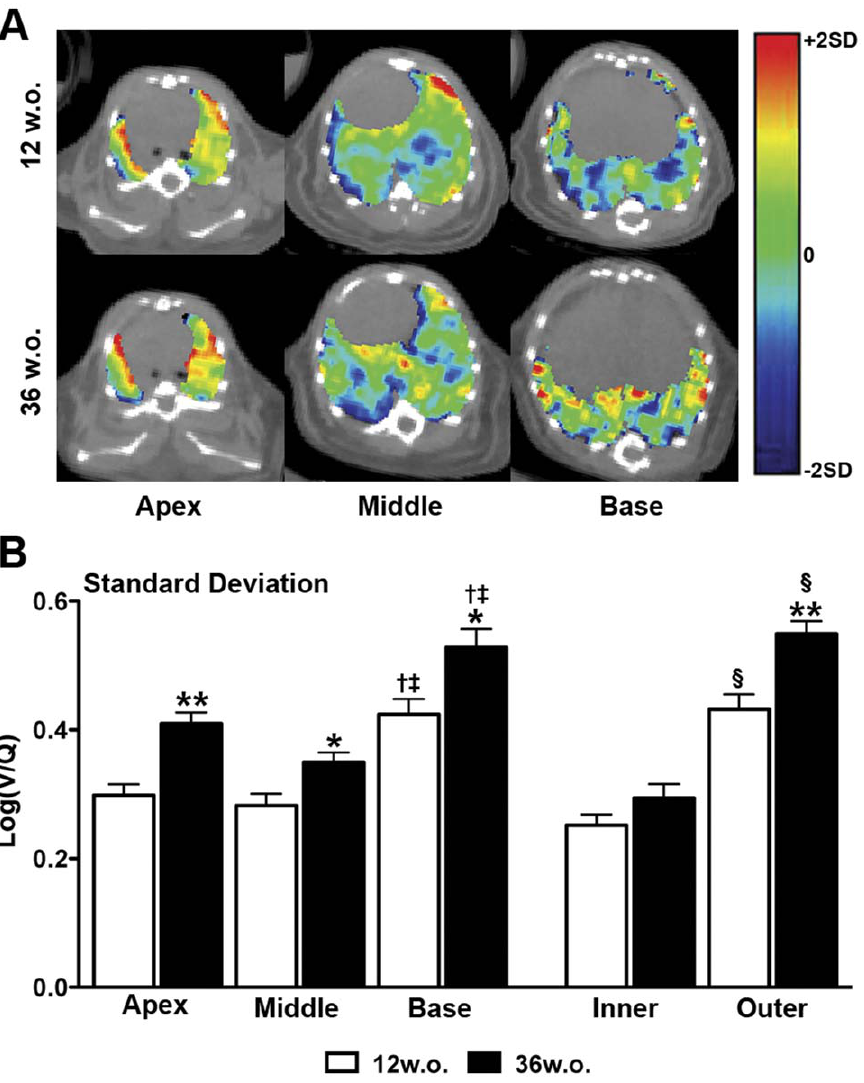
Figure 6. Regionalization of V/Q mismatching. A Representative axial log(V/Q) slices depicting changes with age in the apex, middle, and base of the lung. The colour scale represents 2 average standard deviations from the average mean of 12w.o. animals. B Regional analysis of averaged log(V/Q) standard deviation values in the apex, middle, and base of the lung as well as inner and outer regions. *p , 0.05, **p , 0.01 by two-tailed t- test between 12 and 36w.o. groups. { p , 0.05 apex vs. base, { p , 0.05 middle vs. base by one-way ANOVA with Tukey post-hoc. 1 p , 0.05 by two-tailed t-test between inner and outer regions.